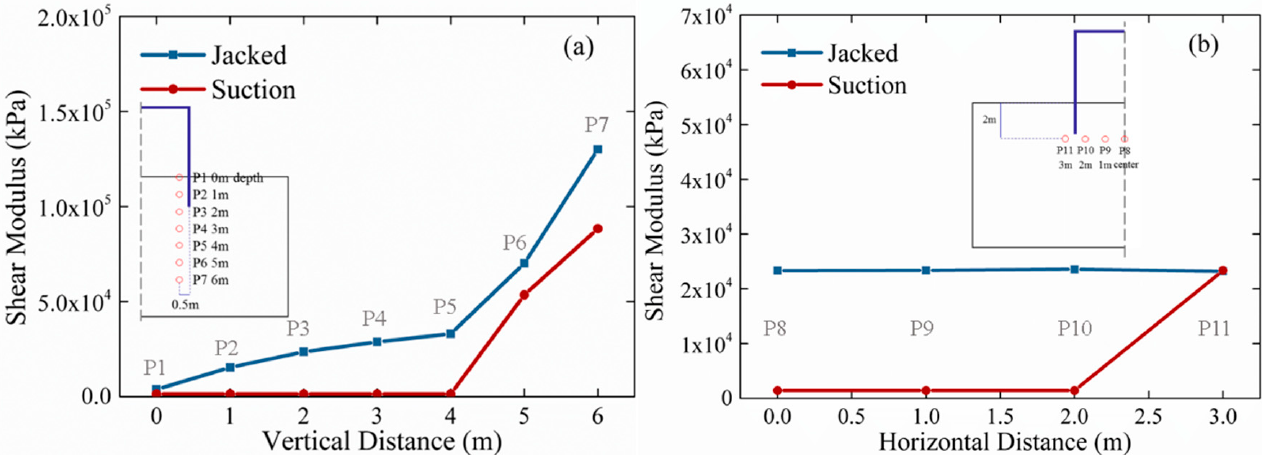
Figure 12. Shear modulus distribution at typical points within the soil at the end of jacked and suction penetration: ( a ) Points P1 to P7 at 0 m to 6 m depths 0.5 m inside the caisson wall; ( b ) Points P8 to P11 at 0 m to 3 m horizontal distances from the center of the caisson at 2 m depth.